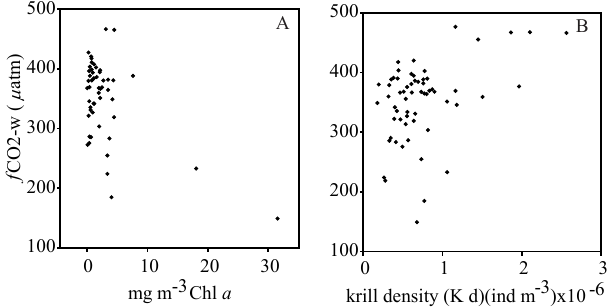
Figure 5. Scatterplots of surface (5m) f CO 2 − w vs. surface (5m) Chl a (A) and krill density (B) . Data combined for all cruises and stations.